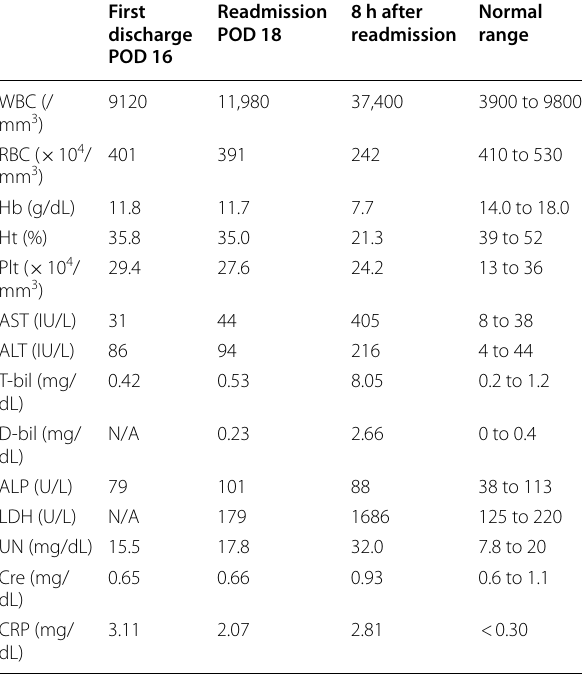
ALP alkaline phosphatase, ALT alanine aminotransferase, AST aspartate aminotransferase, bil total bilirubin, Cre creatinine, CRP C-reactive protein, D-bil direct bilirubin, Hb hemoglobin, Ht hematocrit, LDH lactate dehydrogenase, N/A not available, Plt platelet count, POD postoperative day, RBC red blood cell count, T-UN urea nitrogen, WBC white blood cell